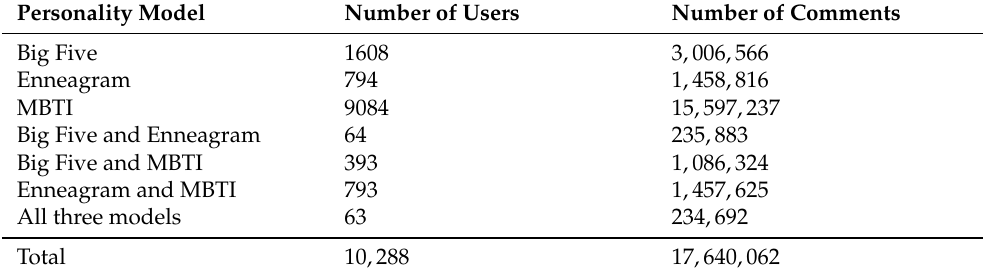
Table 2. The number of users and comments labelled with each of the personality models in the PANDORA dataset. The data in this table were adapted from the work of Gjurkovi´c et al. [7]